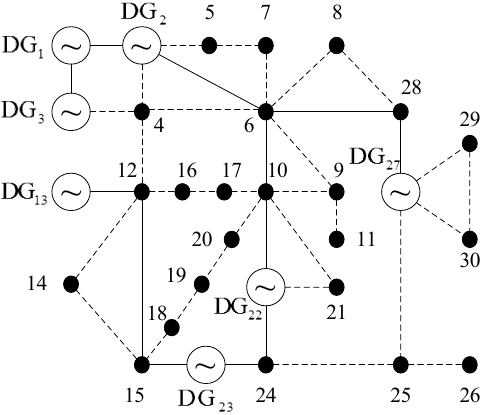
Figure 3. The final restoration backbone network.